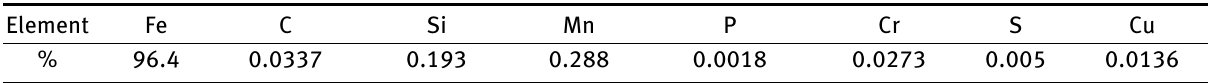
Table 1: Chemical composition of